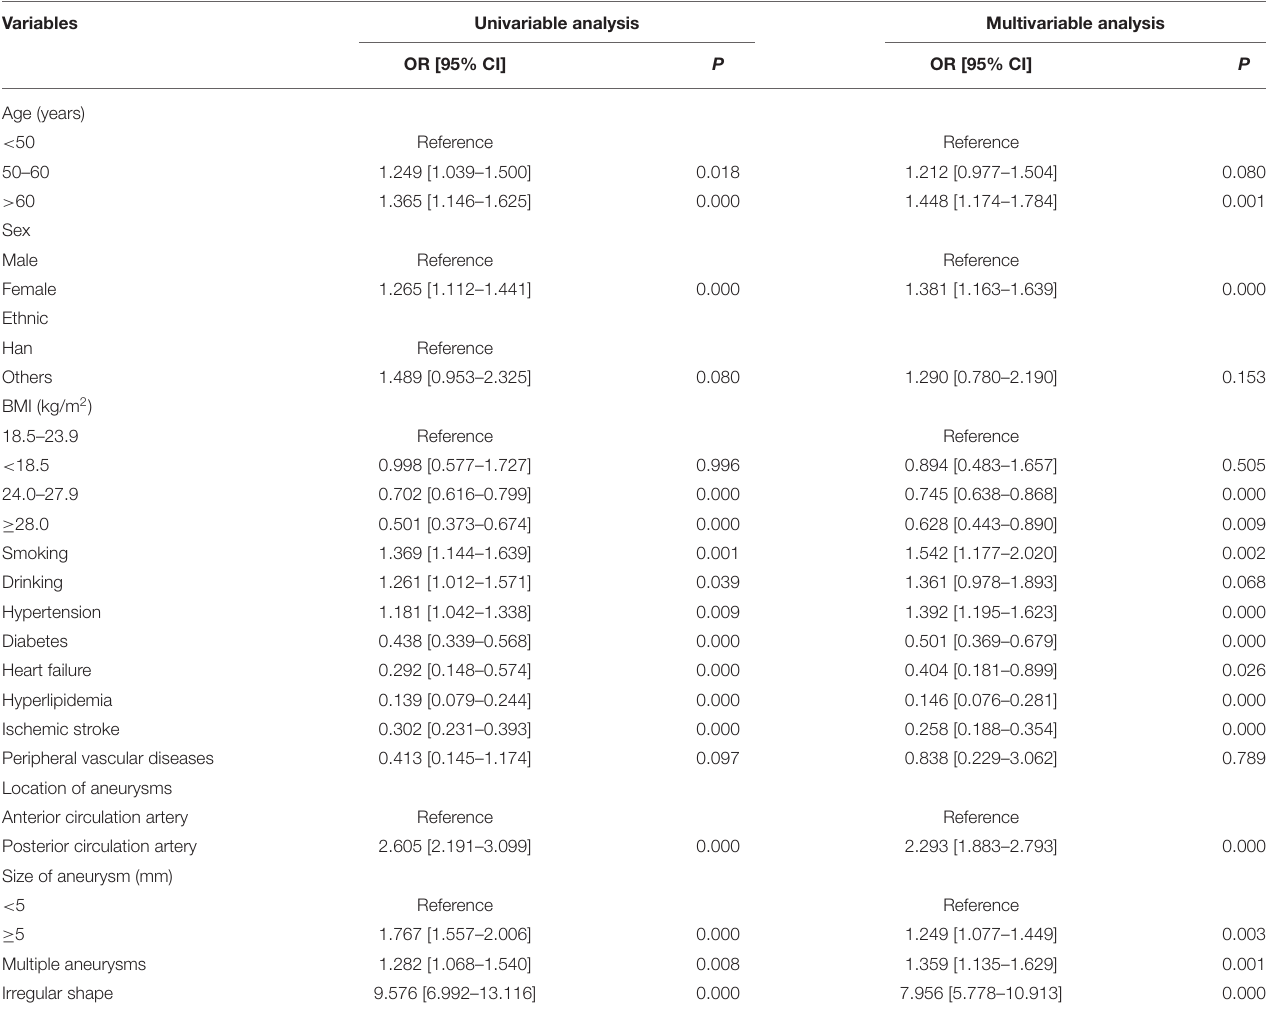
TABLE 2 | Univariable and multivariable analyses for the risk factors of intracranial aneurysm